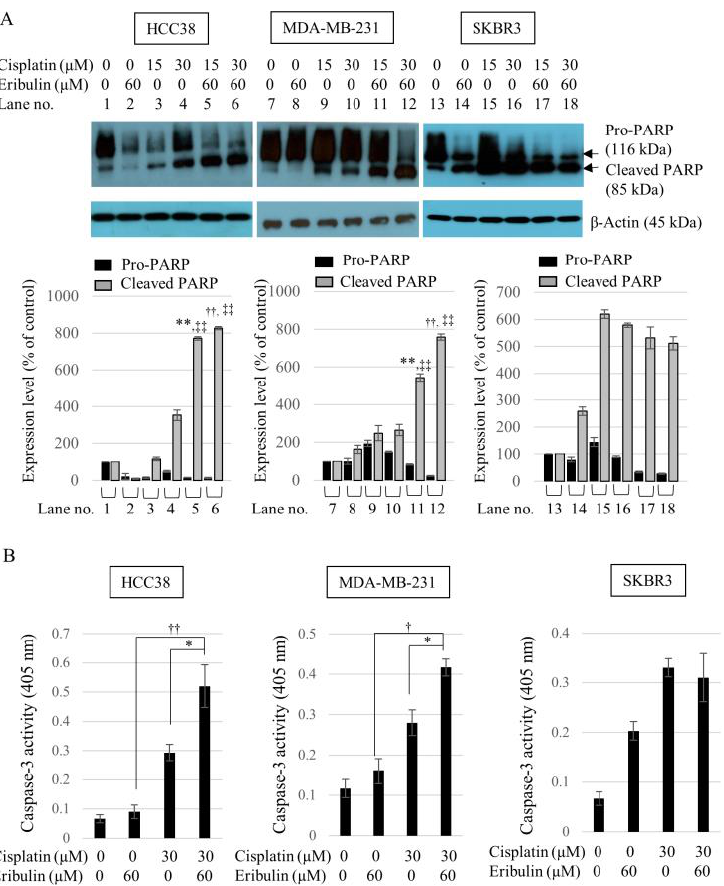
Figure 4. Eribulin enhances the apoptotic effect of cisplatin on TNBC cells. ( A ) HCC38, MDA-MB-231, and SKBR3 cells were exposed to cisplatin (15 and 30 µ M) or eribulin (60 µ M) individually or in combination for 24 h. Cell lysates were collected and subjected to Western blot analysis with the anti-PARP antibody. β -Actin was used as the internal control; ** p < 0.01 vs. cisplatin-only (15 µ M) treatment in cleaved PARP, †† p < 0.01 vs. cisplatin-only (30 µ M) treatment in cleaved PARP, ‡‡ p < 0.01 vs. eribulin-only (60 µ M) treatment in cleaved PARP. ( B ) Cells were treated with cisplatin alone, eribulin alone (60 µ M), or a combination of cisplatin and eribulin for 24 h. The absorbance of pNA (p-nitroaniline) at 405 nm was measured. Results are presented as the mean ± standard deviation from three independent studies; * p < 0.05 vs. cisplatin-only (30 µ M) treatment, † p < 0.05, †† p < 0.01 vs. eribulin-only (60 µ M)